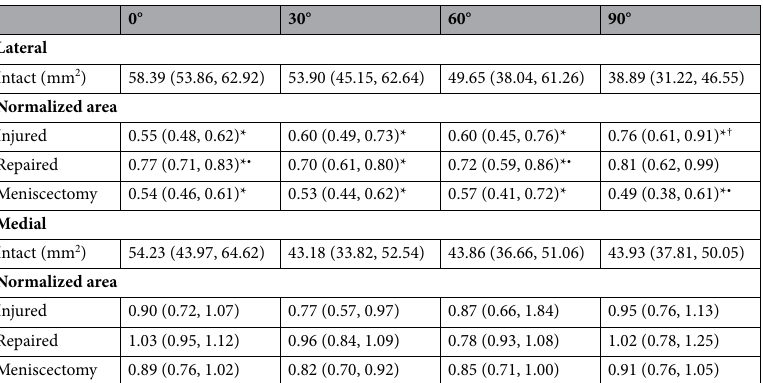
Table 1. Normalized contact area relative to the intact condition in the lateral and medial compartments at each flexion angle for the 3 altered meniscal conditions (given as mean value with the 95% CI in parentheses). Values of contact area (mm 2 ) in the Intact group are provided for reference. *Significant difference with respect to the intact condition. † Significant difference with respect to meniscectomy. • Significant difference with respect to